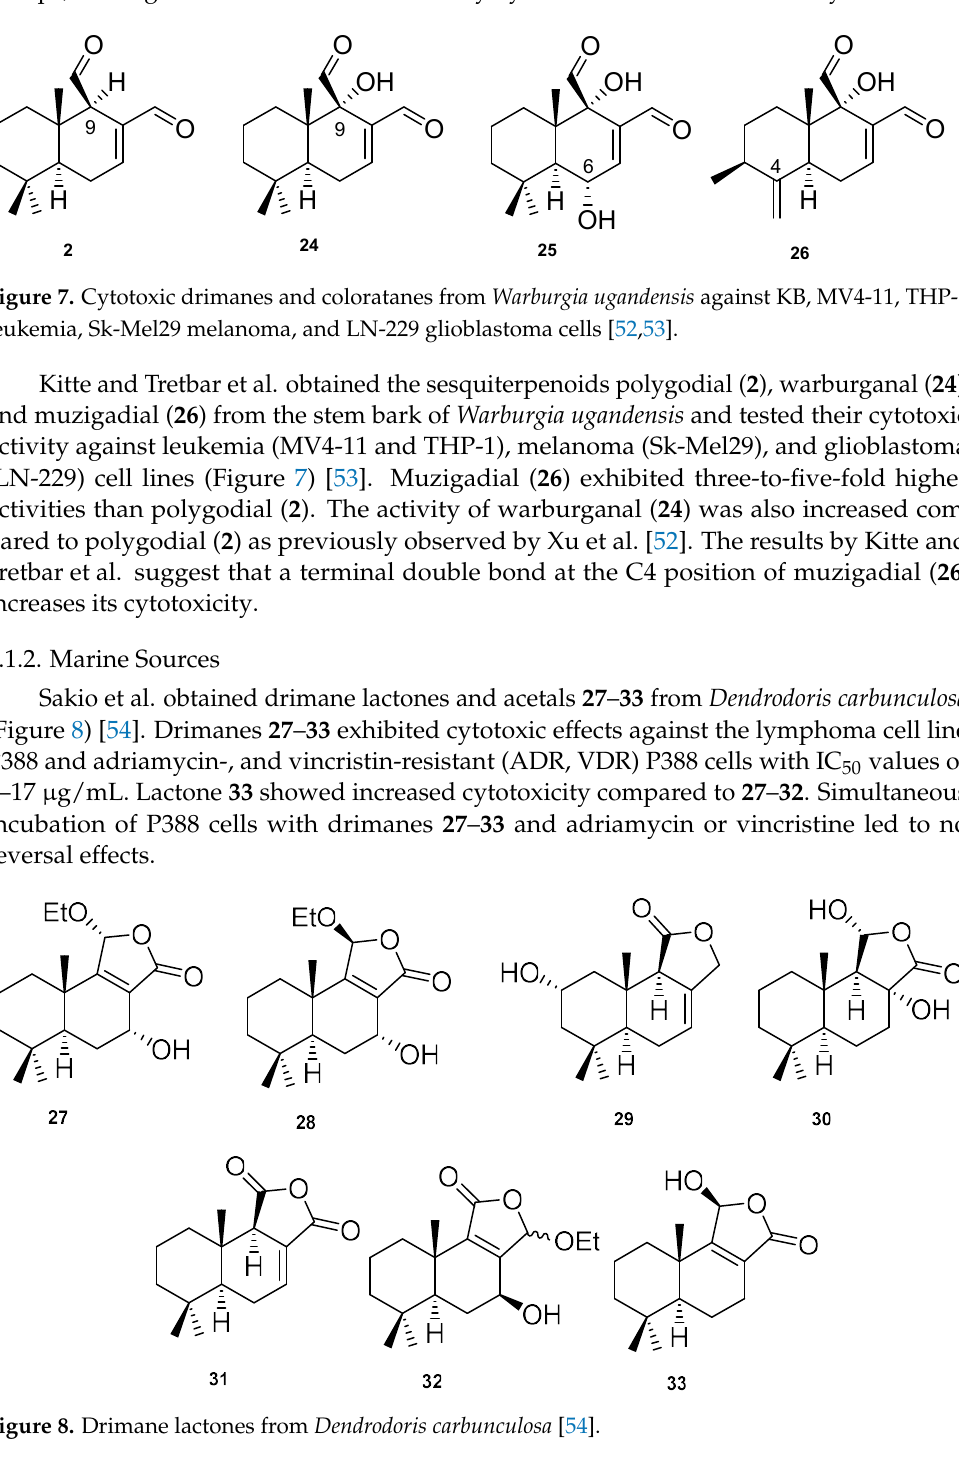
Figure 9. Cytotoxic drimane acetals from Perenniporia maackiae [55]. 2.1.3. Fungal Sources Liu et al. isolated polyene-substituted drimanes 37 – 39 from the fungus Aspergillus ustus and investigated their impact on a murine lymphoma cell line (L5178Y) on PC-12 and HeLa cells (Figure 10) [56]. Compound 37 was shown to be cytotoxic towards all cancer cell lines, whereas 38 and 39 were less active than 37 . In general, L5178 cells were more susceptible towards 37 – 39 than PC-12 and HeLa cells. Lu et al. also obtained the polyene-substituted drimanes 37 and 38 and an additional compound 40 from Aspergillus ustus and investigated their cytotoxicity against A549 carcinoma and HL-60 leukemia cell lines (Figure 10) [57]. The highest activities were observed for 37 and 40 . Surprisingly, 37 exhibited no cytotoxicity against A549 cells and 40 no activity against HL-60 cells. For 38 only a minor impact against A549- and HL-60 cells was observed. The results by Liu et al. and Lu et al. suggest that hydrophilic and electron-deficient groups at the terminal position of the conjugated π-system (Figure 10, green circle) are beneficial for an increase in cytotoxic activity [56,57].